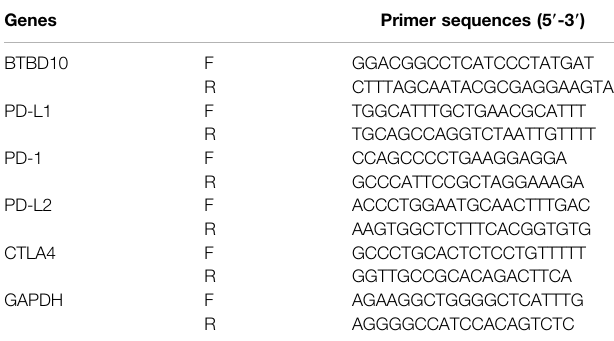
TABLE 1 | Primer sequences of quantitative real-time polymerase chain reaction